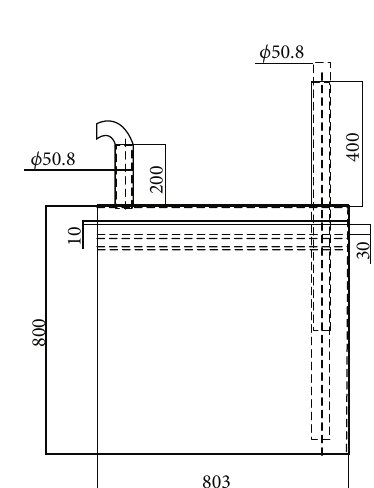
Figure 3: The line diagram of CO